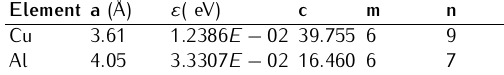
Table 1. The parameters associated with the RS potential function for Cu and Al fcc metals. Element a